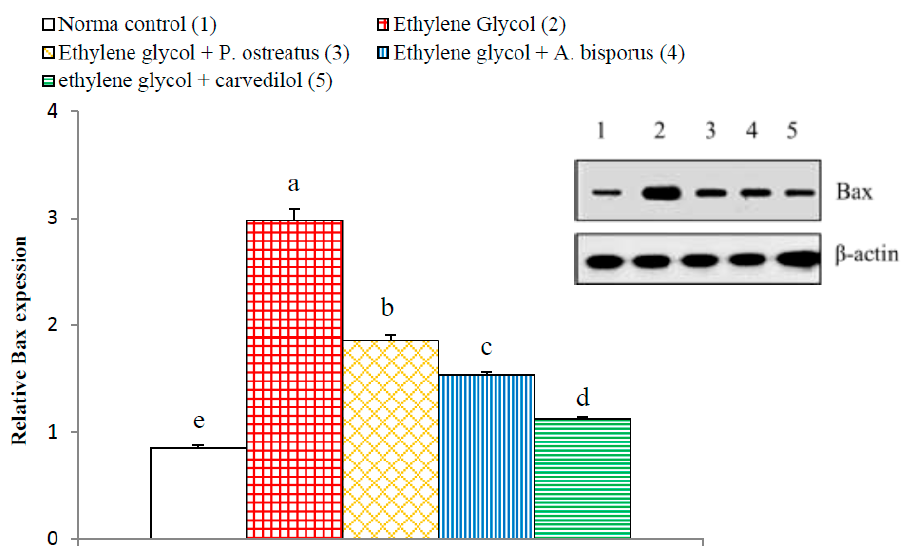
Figure 22. Effect of P. ostreatus and A. bisporus aqueous extracts and carvedilol on relative kidney NF- κ B p50 expression detected by Western blot in ethylene glycol-administered rats. Means which share the same letter(s) are not significantly different.